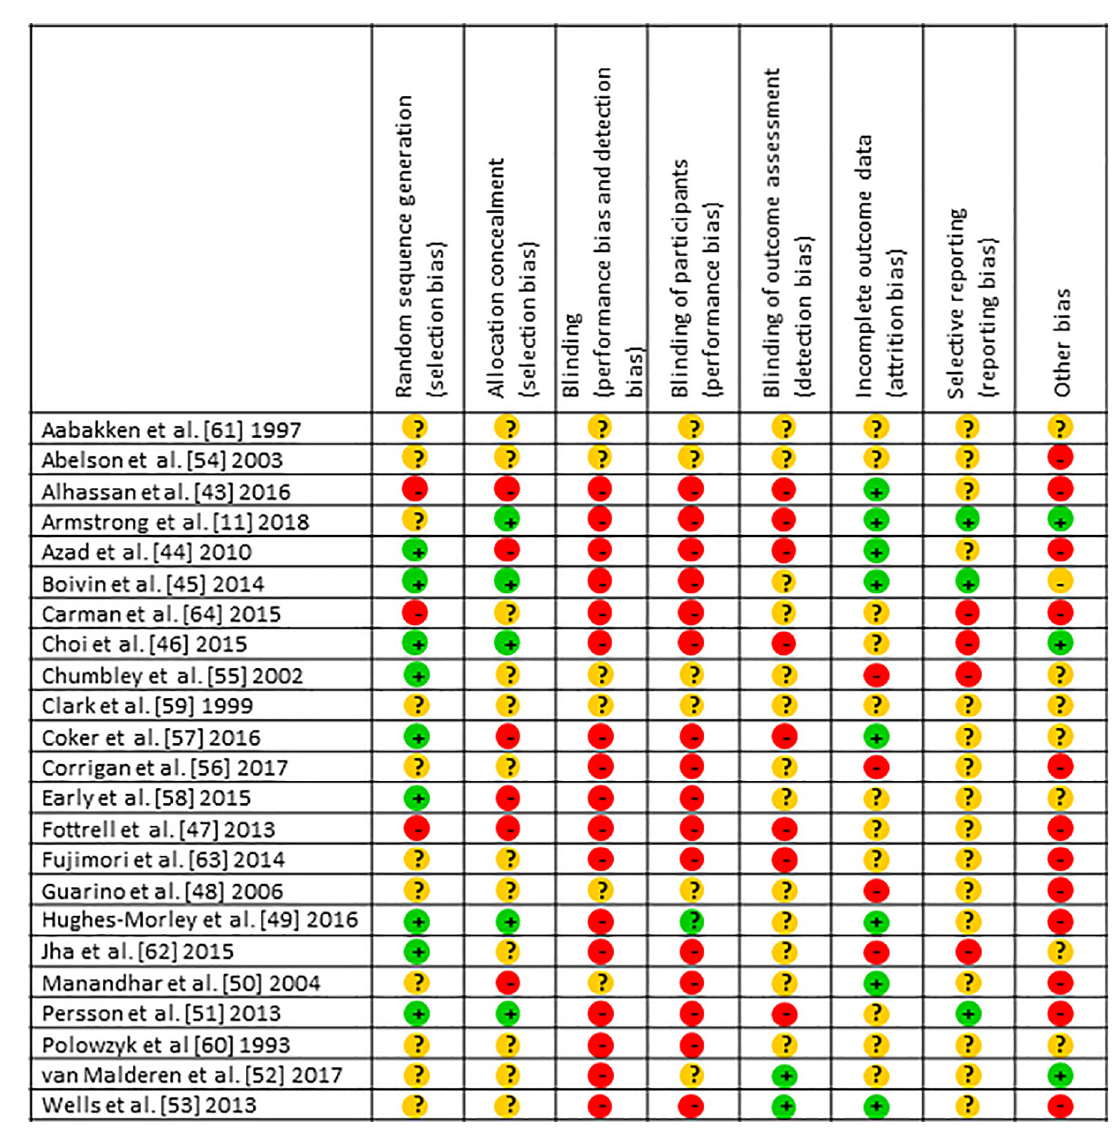
Fig 2. Risk of bias of included studies.